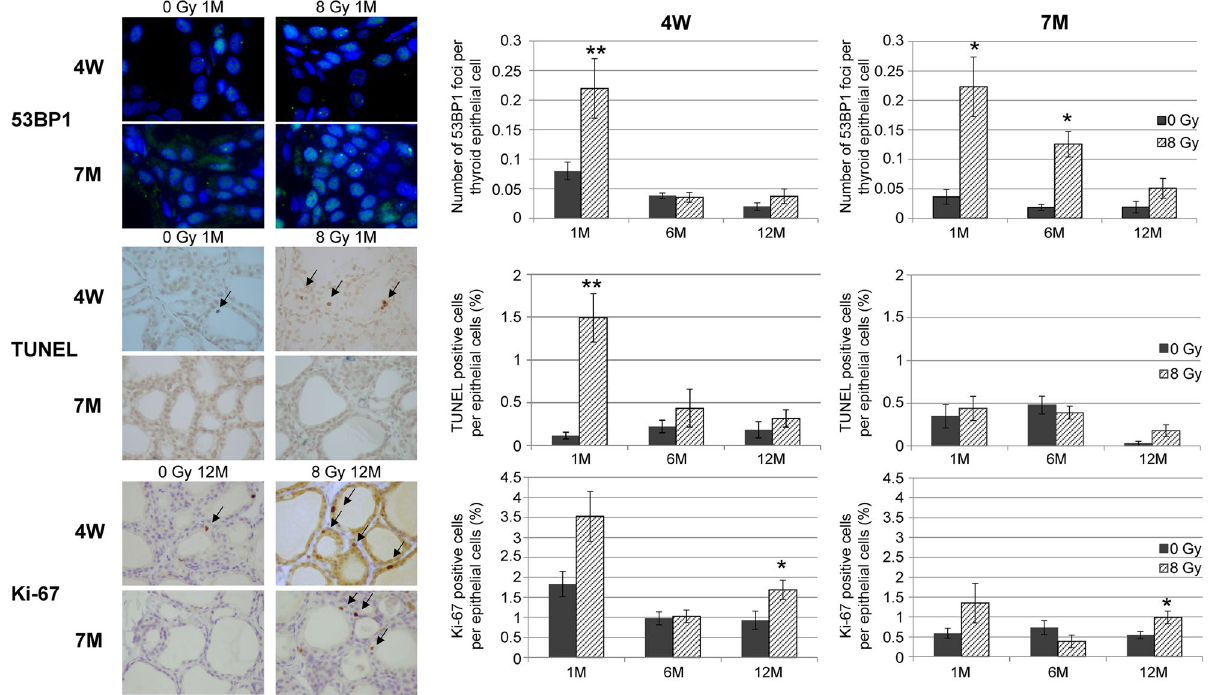
Figure 2. Changes in 53BP1 foci and TUNEL- and Ki-67-positive cells in nonirradiated (control) and irradiated 4W and 7M thyroid follicular epithelial cells at 1, 6, and 12 months after irradiation. Data are expressed as mean ± SEM of four to six rats per data point. * p < 0.05 and ** p < 0.01 vs. nonirradiated